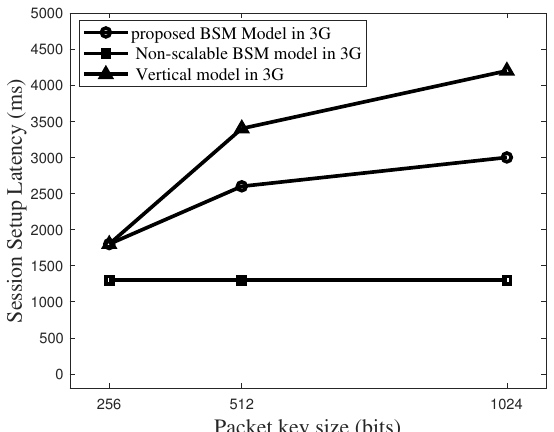
Figure 17. Total latency to set up a packet key-based secure session in 3G networks for the case size of Blind Value Vector (m) =